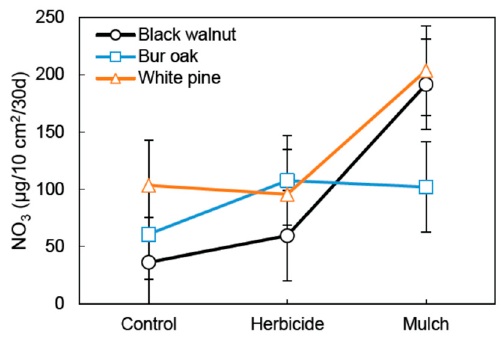
Figure 2. Species × Vegetation treatment interaction for soil NO 3 supply rate ( p = 0.11) measured for 30 days (21 June to 21 July) of the fifth growing season in an agricultural riparian buffer. Vertical bars represent standard error of the difference (SED). Table 2. A priori contrasts for the analysis of variance (ANOVA) testing the effects of Species and Vegetation treatment on soil NO 3 supply rate measured during the fifth growing season.